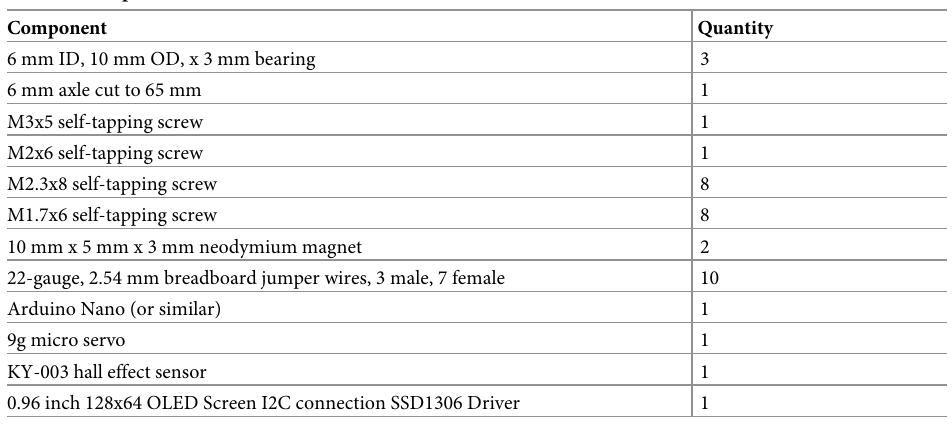
Table 1. Component list for the